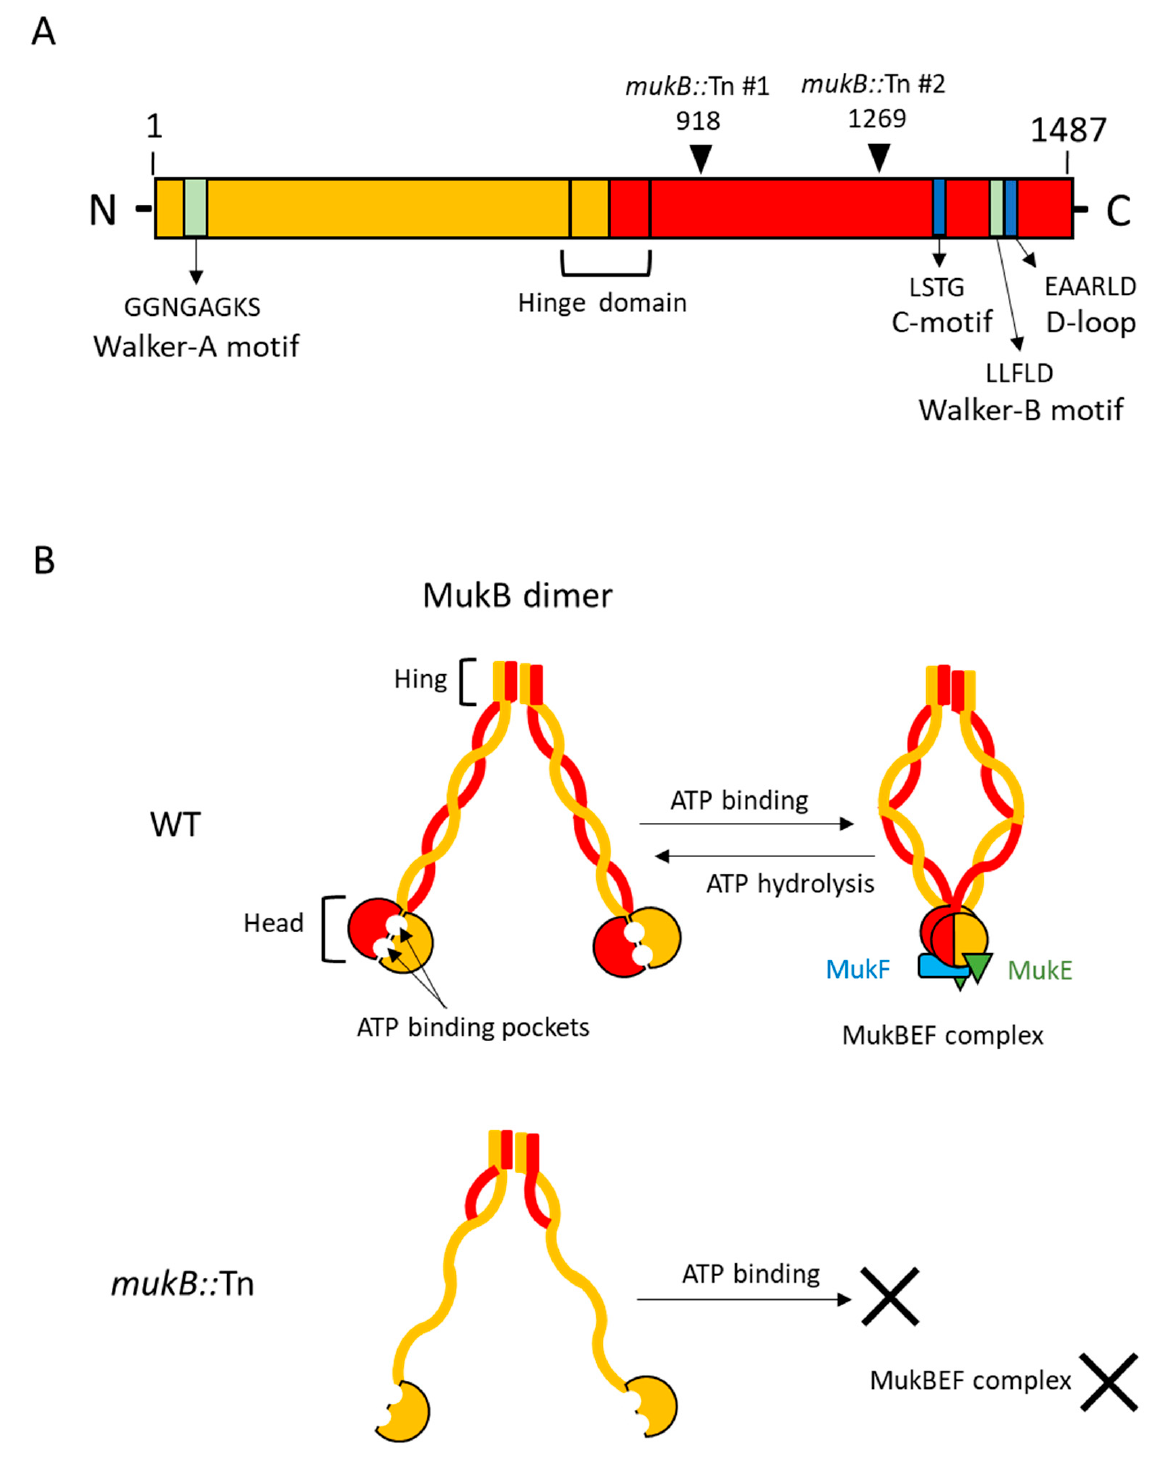
Figure 1. Prediction of the structure-function relationship of mukB ::Tn. ( A ) Second structure of V. vulnificus MukB. Location and the amino acid sequences of Walker A, C motif, Walker B, D loop, and hinge domain were represented. Arrowheads indicate the predicted expression site of each mukB ::Tn clone. ( B ) Structure and function relationship of MukB expressed in WT and mukB ::Tn #1.